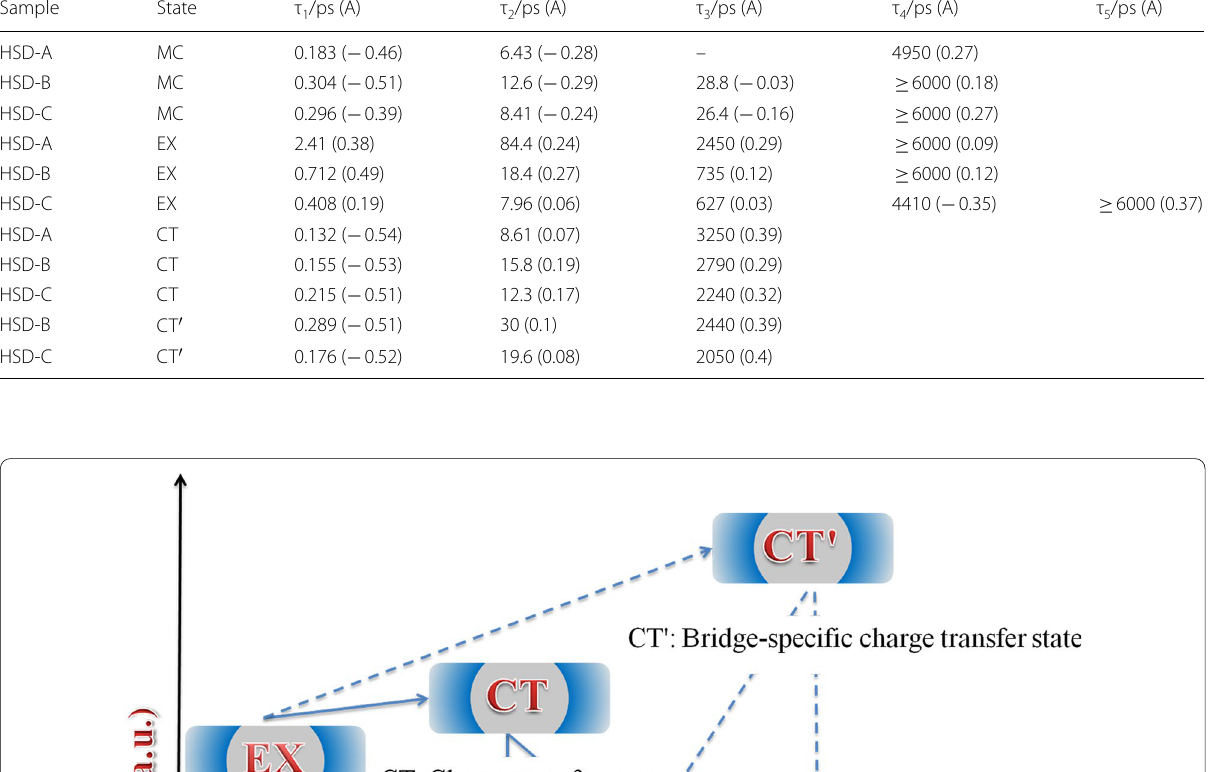
Table 1 Transient absorption kinetics fitting parameters [lifetime (τ) and weight coefficient (A)] of MC, EX, CT, and CT ′ state Sample